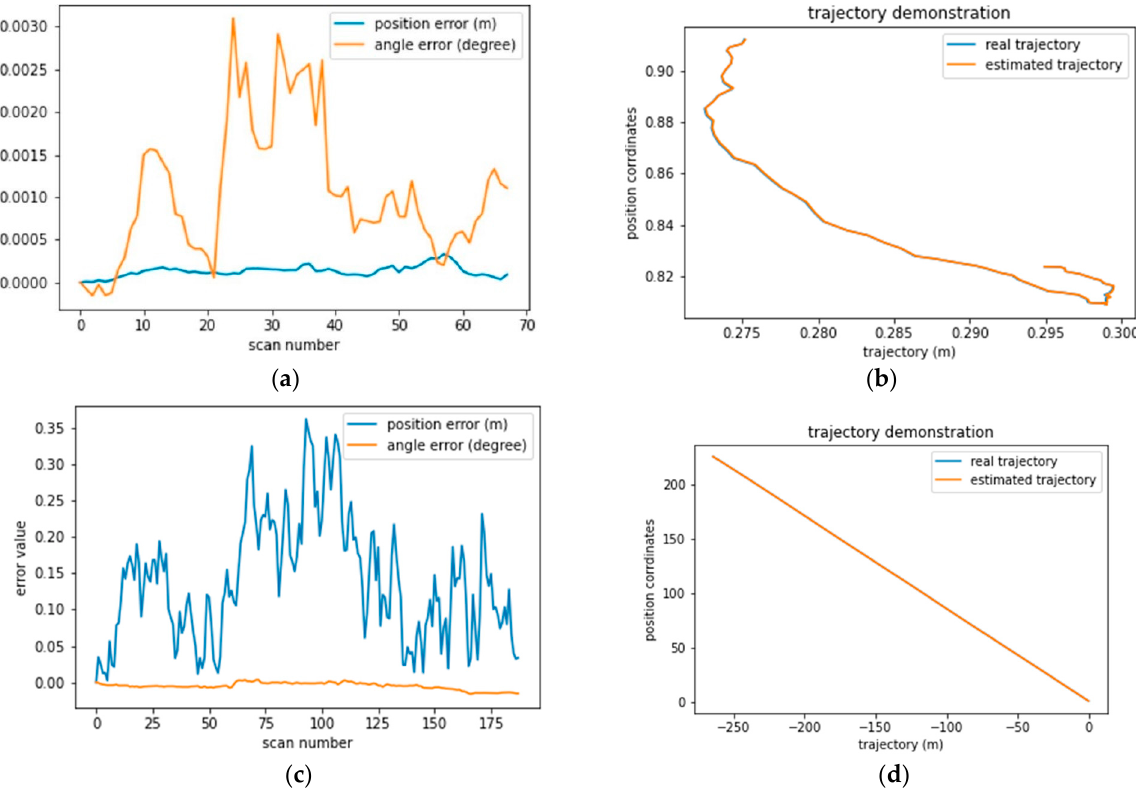
Figure 8. Graphical display of the average absolute position and angular error relative to the vehicle path for each sequence. ( a ) positional and angular error in seq 0053. ( b ) vehicle trajectory in seq 0053. ( c ) positional and angular error in seq 0027. ( d ) vehicle trajectory in seq 0027.